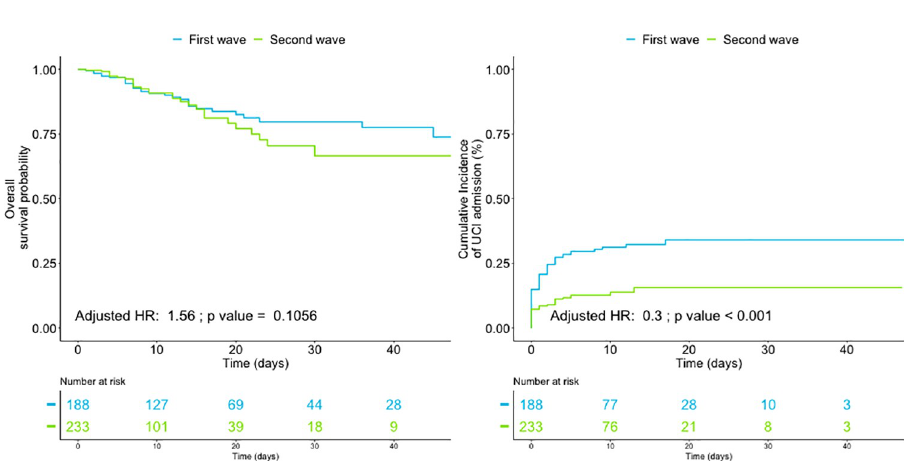
Fig 1. Survival analysis of overall mortality and ICU admission by waves. Adjusted HR = adjusted hazard ratio.